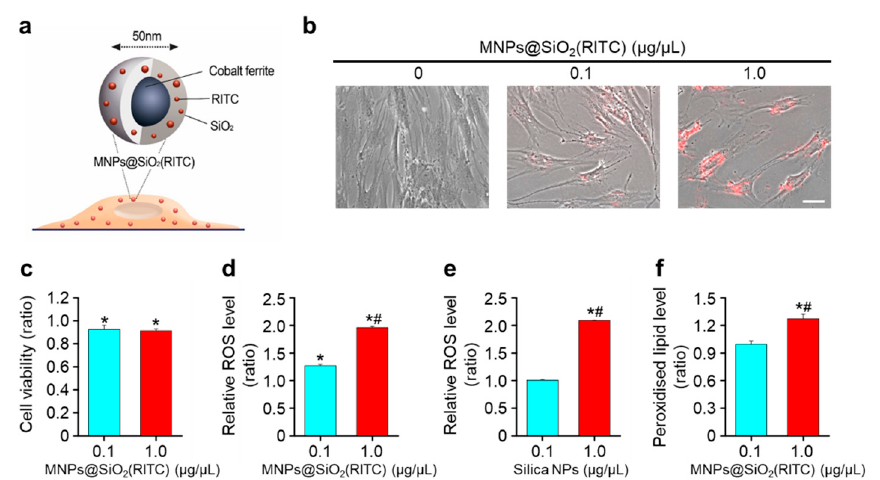
Figure 1. Intracellular reactive oxygen species (ROS) generation and lipid peroxidation in MNPs@SiO 2 (RITC)-treated hBM-MSCs. ( a ) Schematic showing MNPs@SiO 2 (RITC) composition. ( b